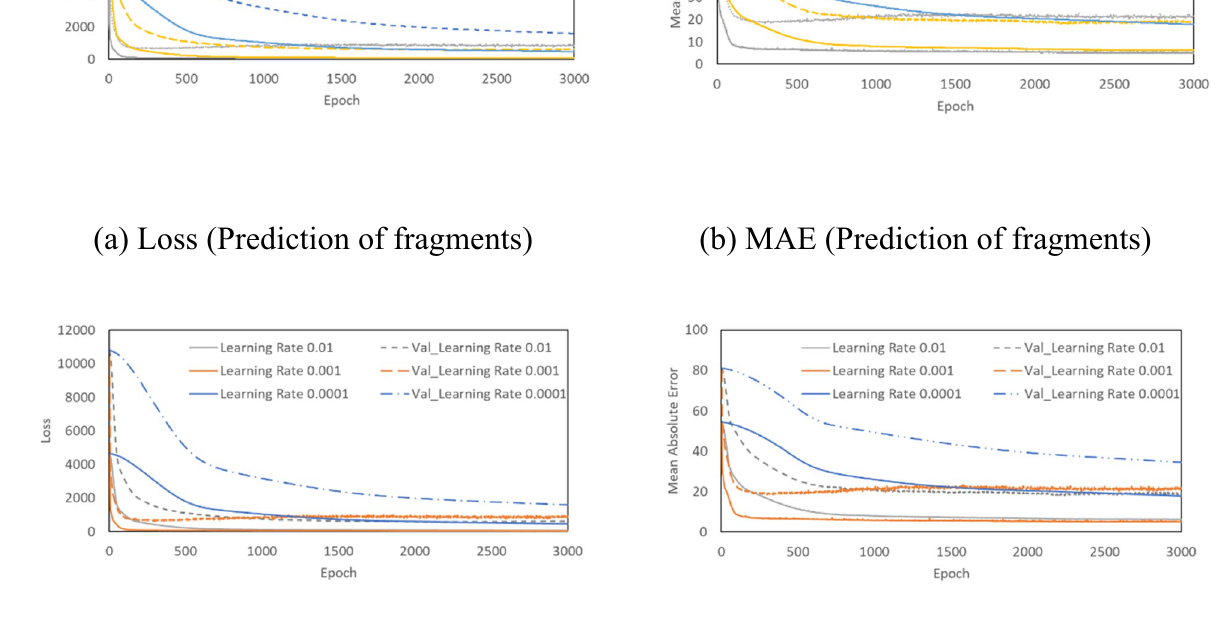
Figure 7. Loss and MAE depending on the learning